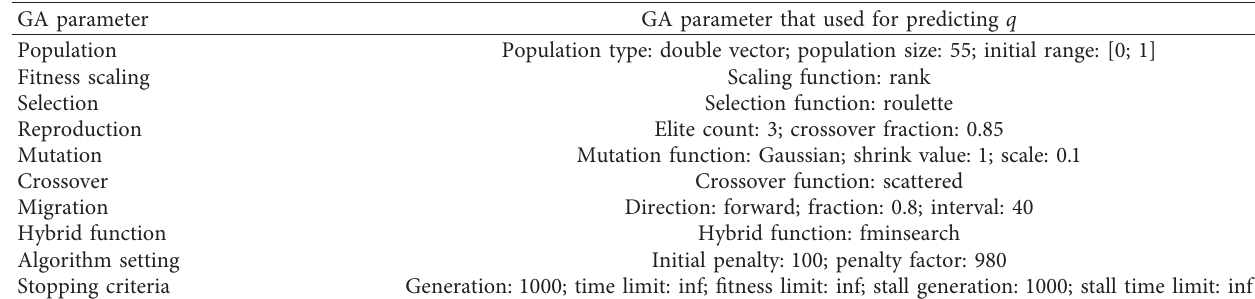
Table 4: Parameters used in the GA for predicting q